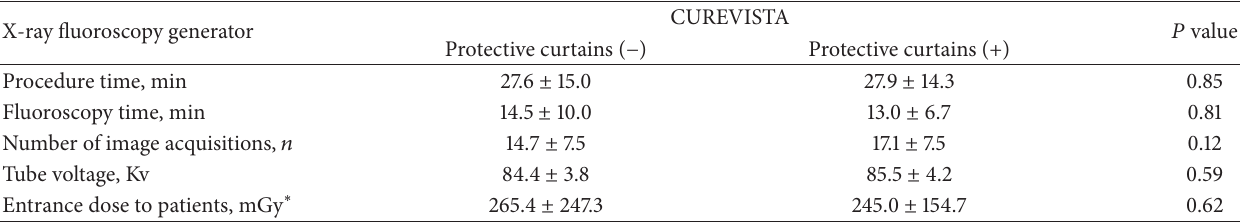
Table 1: ERCP conditions.